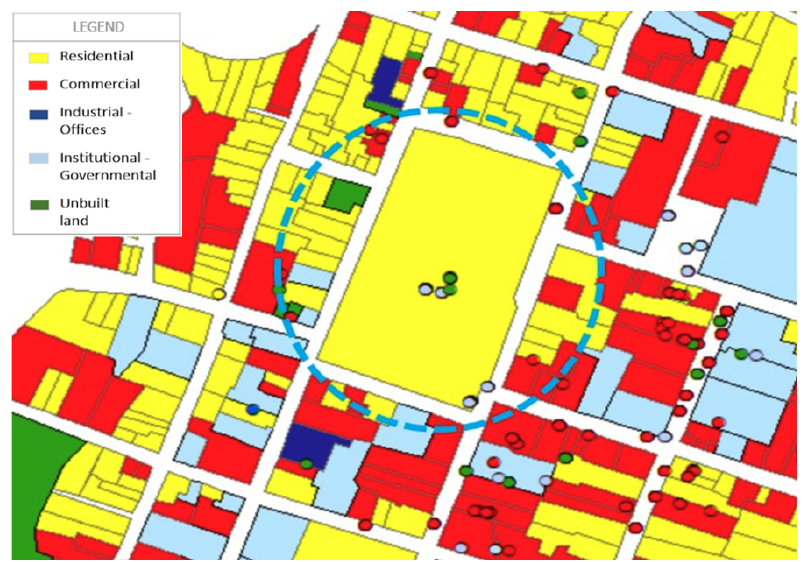
Figure 7. The highlighted area corresponds to the convent of Santa Catalina (in the cadastre it is wrongly classified as residential land